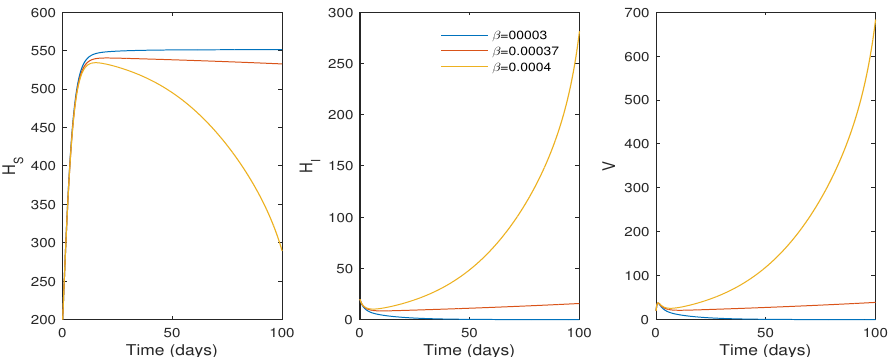
Figure 3. The effect of the infection rate ( β ) on the system trajectories with β = 0.0003, 0.00037 and 0.0004; time t in days; and the values of the parameters as given in Table 1.